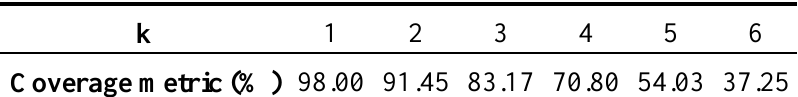
Table 2. The initial coverage metric of k-coverage area.